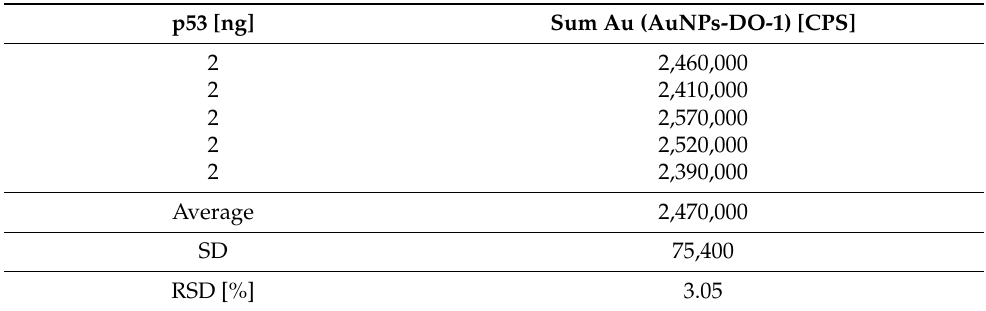
Table 2. Repeatability of measurement: Measured Au intensities and calculated standard deviation and relative standard deviation.